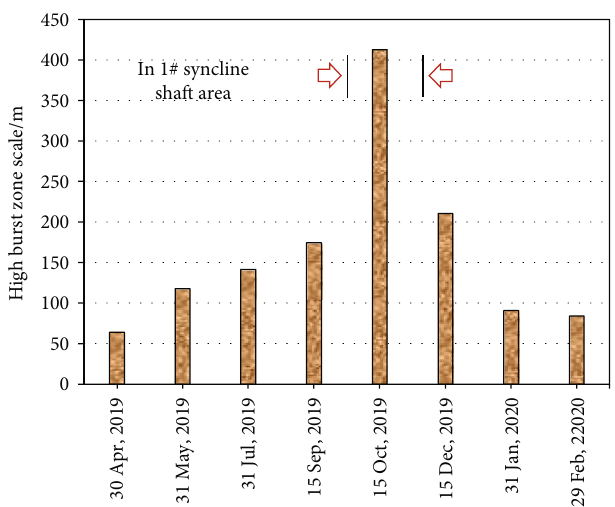
Figure 7: High burst zone scale (middle and strong burst zone) in front of the face line.